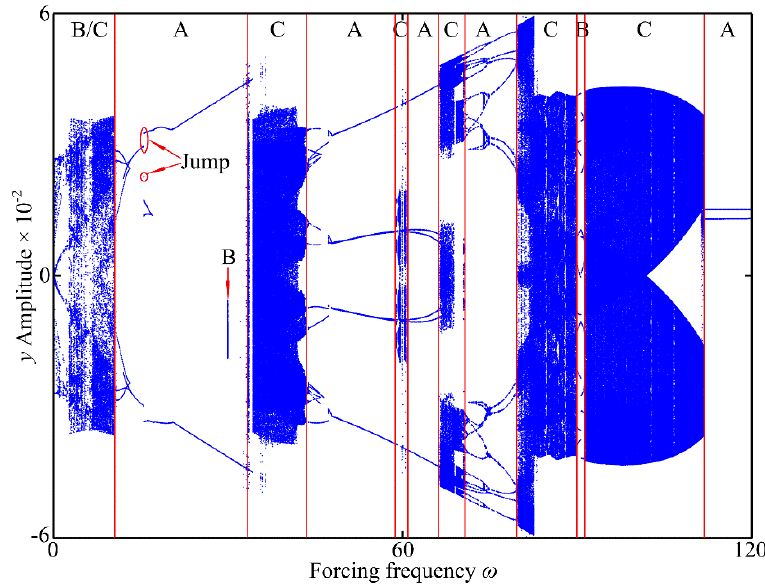
Figure 3. Bifurcation diagram of system response with ω , k a = k b = 0 (A: periodic motion; B: quasi- periodic motion; C: chaotic motion).